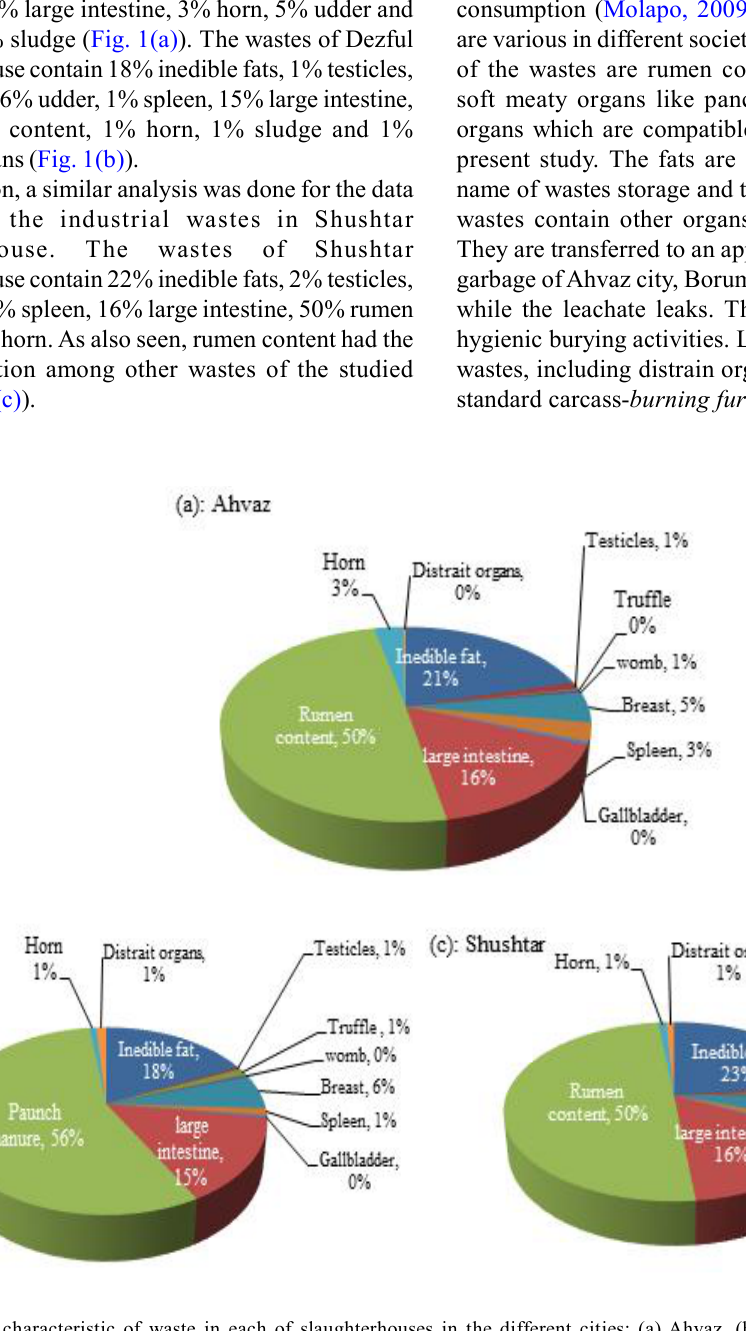
Fig. 1: The characteristic of waste in each of slaughterhouses in the different cities: (a) Ahvaz, (b) Dezful, (c)